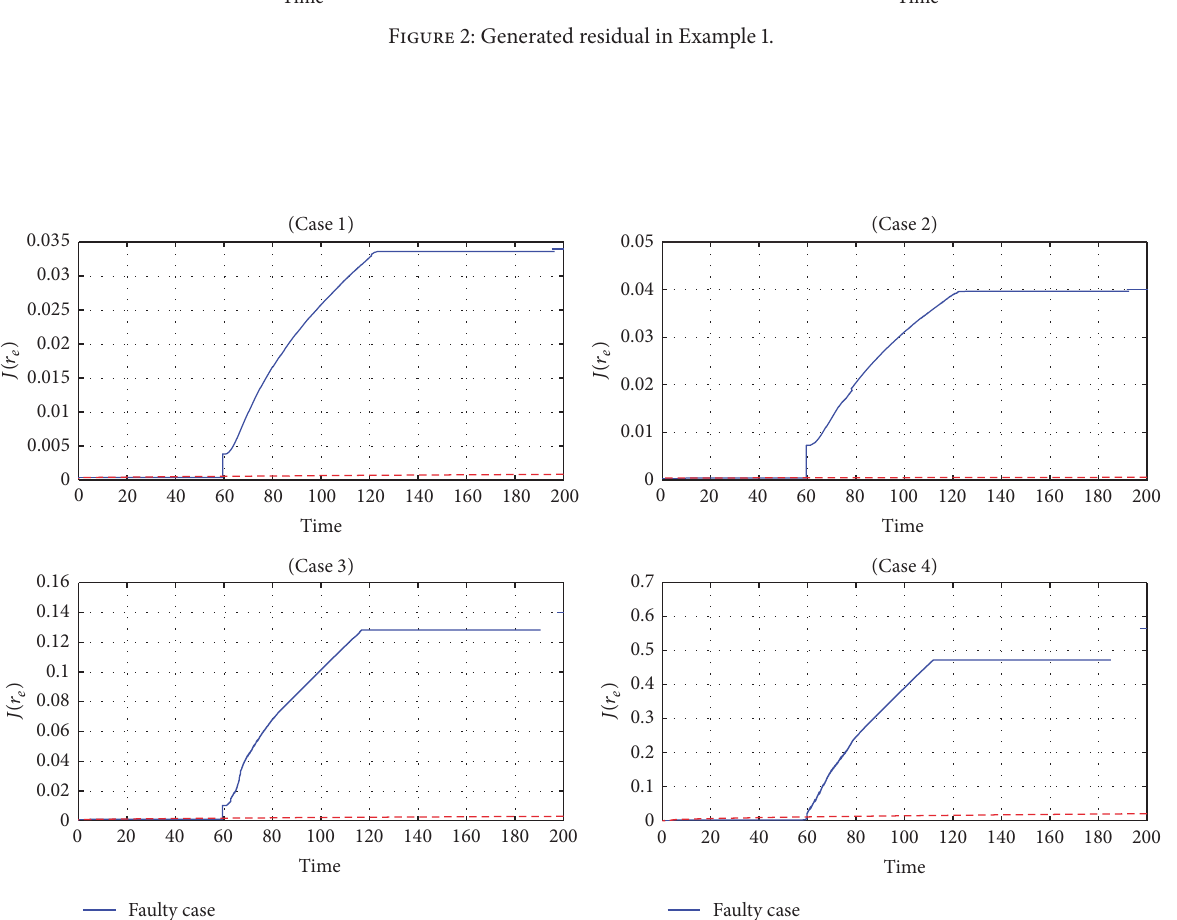
Figure 2: Generated residual in Example 1.